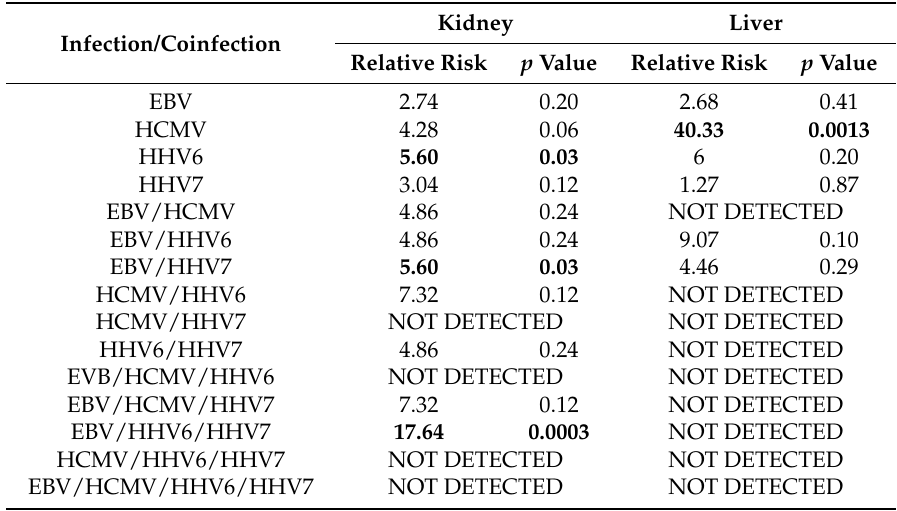
Table 5. Relative risk of organ